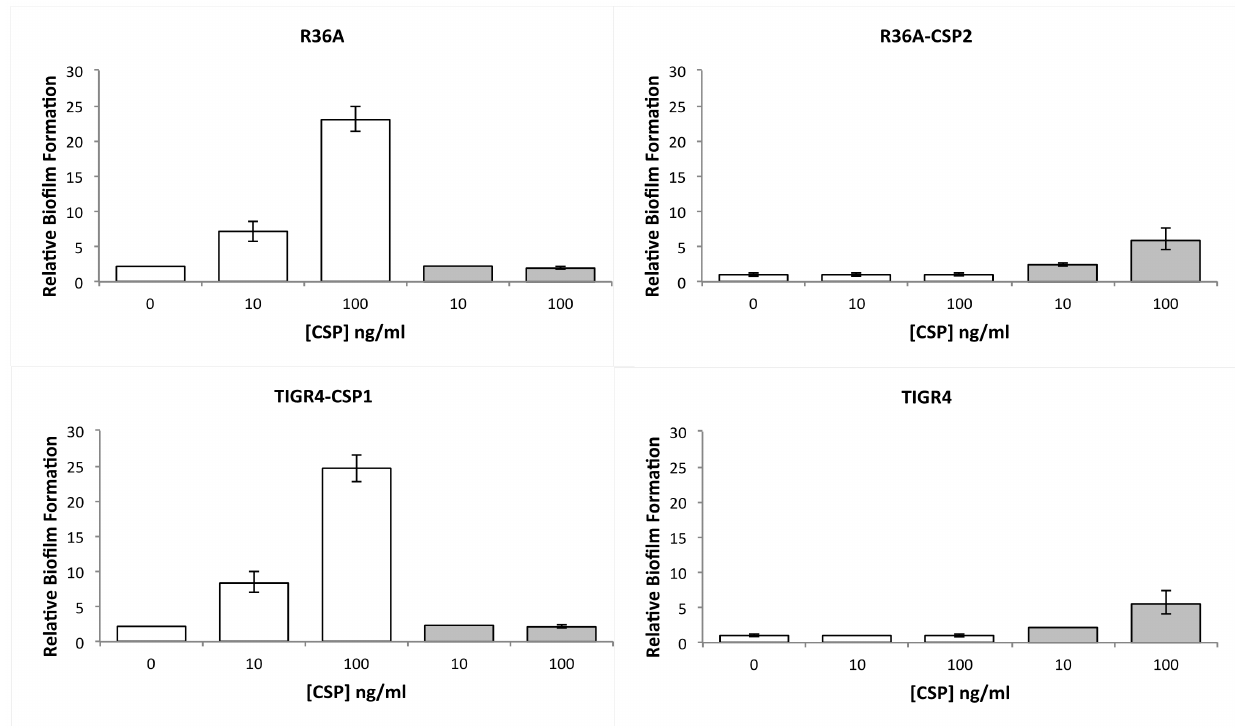
Figure 2. Biofilms of wild type and pherotype switched strains respond to cognate CSP in a dose-dependent manner. R36A and R36A- CSP2 and TIGR4-CSP1 and TIGR4 were incubated with synthetic CSP1 (white bars) and synthetic CSP2 (grey bars) during a biofilm growth experiment. Biofilm response to CSP was evaluated by determination of CFUs detached from the 96-well-plates after 24 h of incubation. Plotted values are relative to the average number of CFUs per well obtained for TIGR4 strain without adding CSP (2.0 6 10 8 CFU/well). Error bars represent 95% confidence intervals for the mean of 3 independent experiments each with 3 technical replicates. Both strains were responsive to their cognate CSP but not to their heterologous CSP.